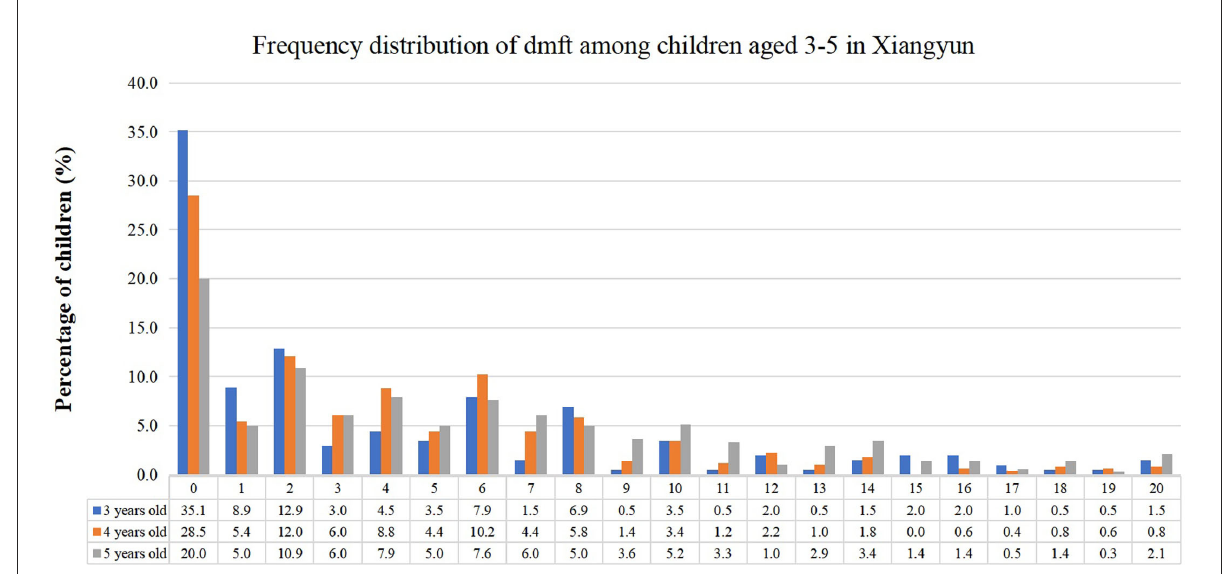
FIGURE1 Frequency distribution of dmft among 3–5-year old children in Xiangyun,